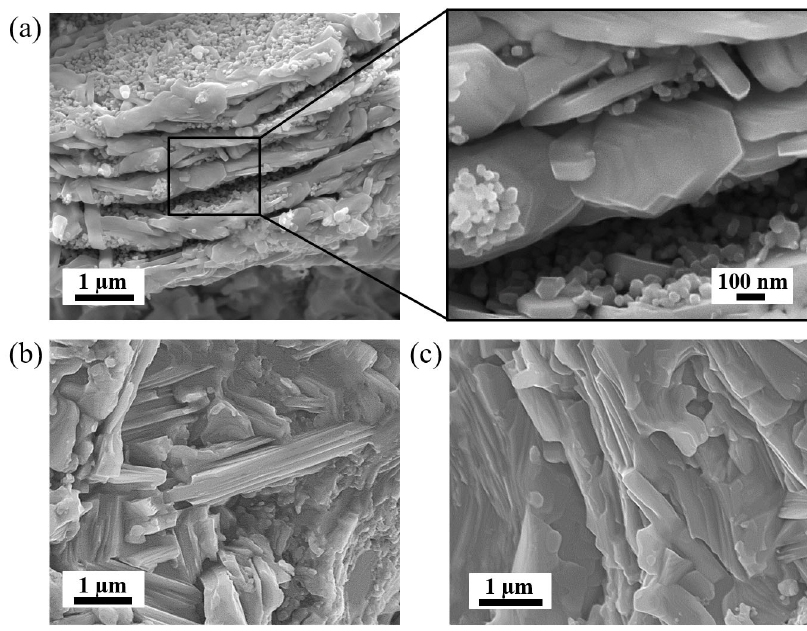
Fig. 4 Microstructure of (a) V 2 SnC powders and (b, c) fracture surfaces of V 2 SnC bulk fabricated by SPS.